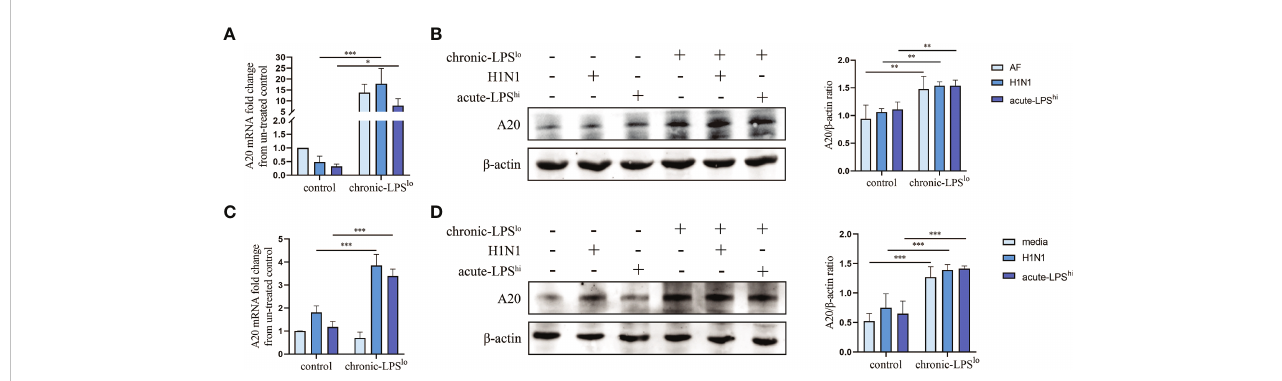
FIGURE 3 Effect of chronic low-dose LPS stimulation on A20. (A) A20 mRNA in lung tissues was detected by qPCR. (B) Relative protein levels of A20 in lung tissues were detected by western blot. (C) A20 mRNA in A549 cells was detected by qPCR. (D) Relative protein levels of A20 in A549 cells were detected by western blot. Data are mean ± SD, n = 3. *p< 0.05, **p< 0.01, ***p<